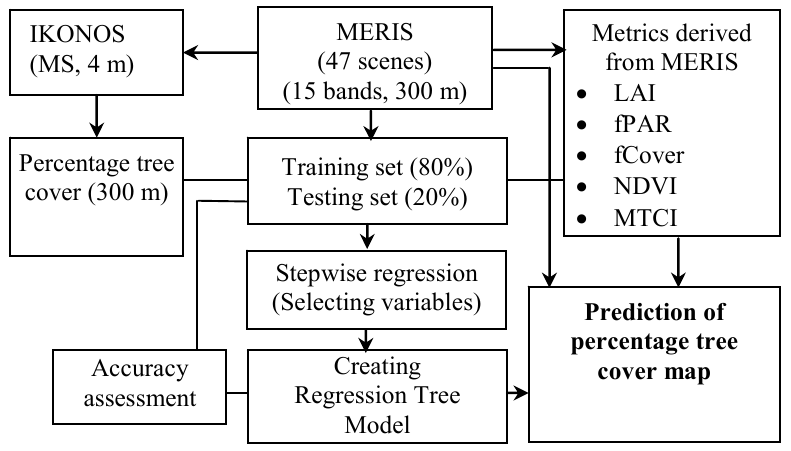
Figure 4. Procedure of estimating fractional tree cover using regression tree